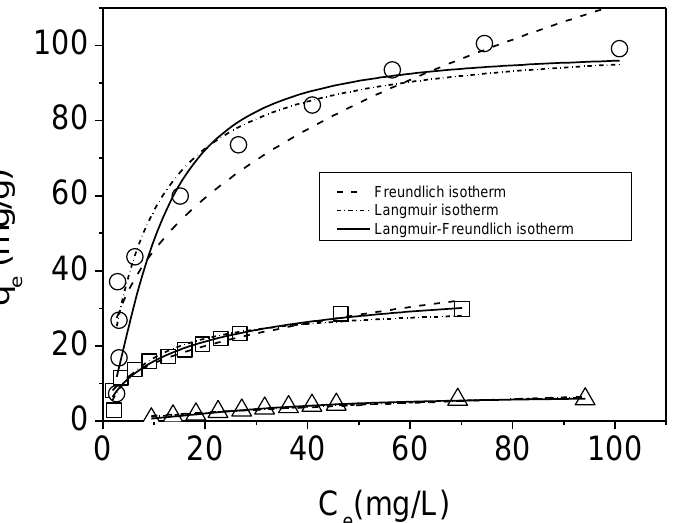
Figure 9. Adsorption isotherms of dye removal on (ο) B -Act- CTAB300, (□) B - CTAB and (Δ) B -Act- CTAB100 samples. Conditions: dye concentration C 0 = 10 to 200 mgL −1 ; adsorbent dosage m s = 1 g/L; pH = 6; T = 298 ± 1 K.